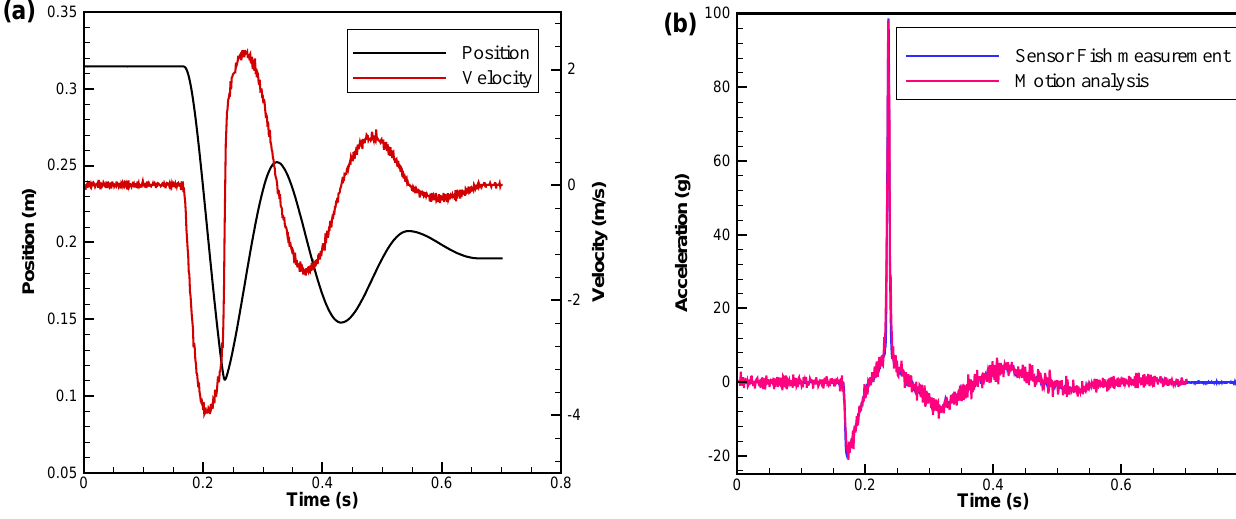
Figure 6 . An example of calibration of linear acceleration in x-direction by comparing the Sensor Fish measurements and motion analysis results, using the collision